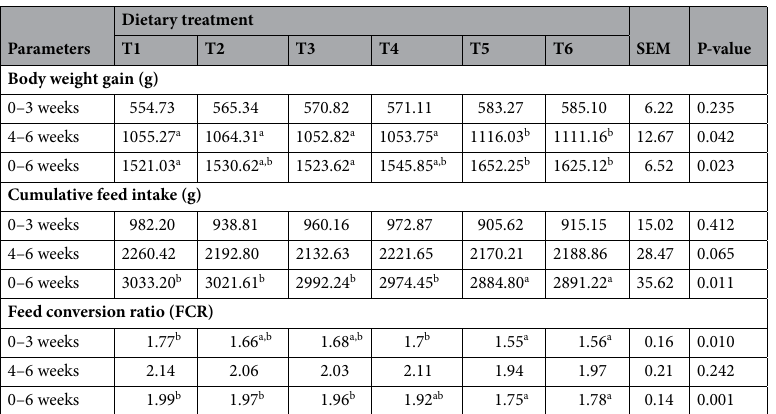
Table 2. Effect of para-probiotic on production performance in broiler chickens (0–6 weeks). Mean values bearing the same superscript in a row did not differ significantly (P < 0.05). T 1 = control, T 2 = 0.02% CTC (w/v), T 3 = 0.2% PPB (w/v); T 4 = 0.4% PPB (w/v); T 5 = 0.6% PPB (w/v); T 6 = 0.8% PPB (w/v). CTC Chlortetracycline.